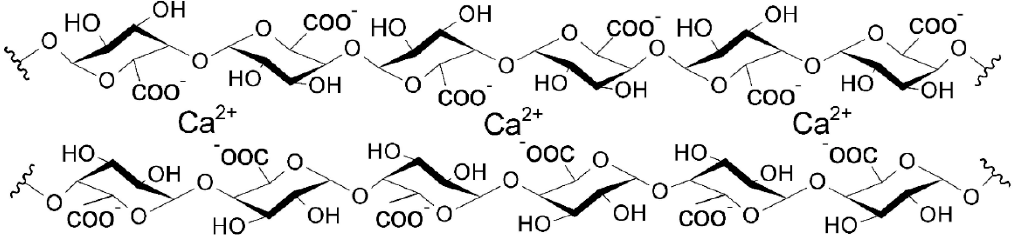
Figure 3. Scheme of “egg-box” model, based on: [77,98,100].